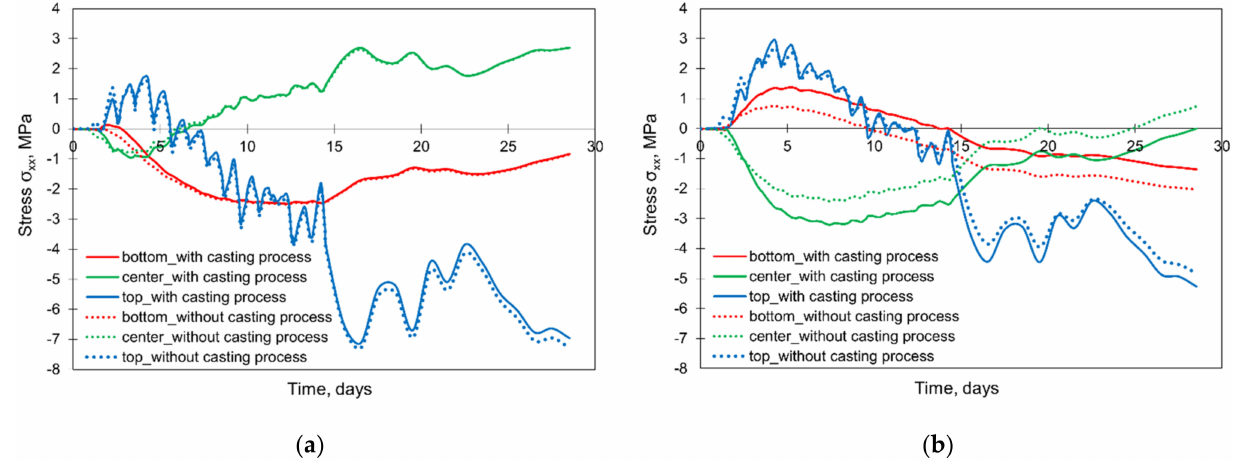
Figure 14. The influence of the casting modelling on the development of stress σ xx in the slabs with thicknesses of ( a ) 2 m and ( b ) 4 m.